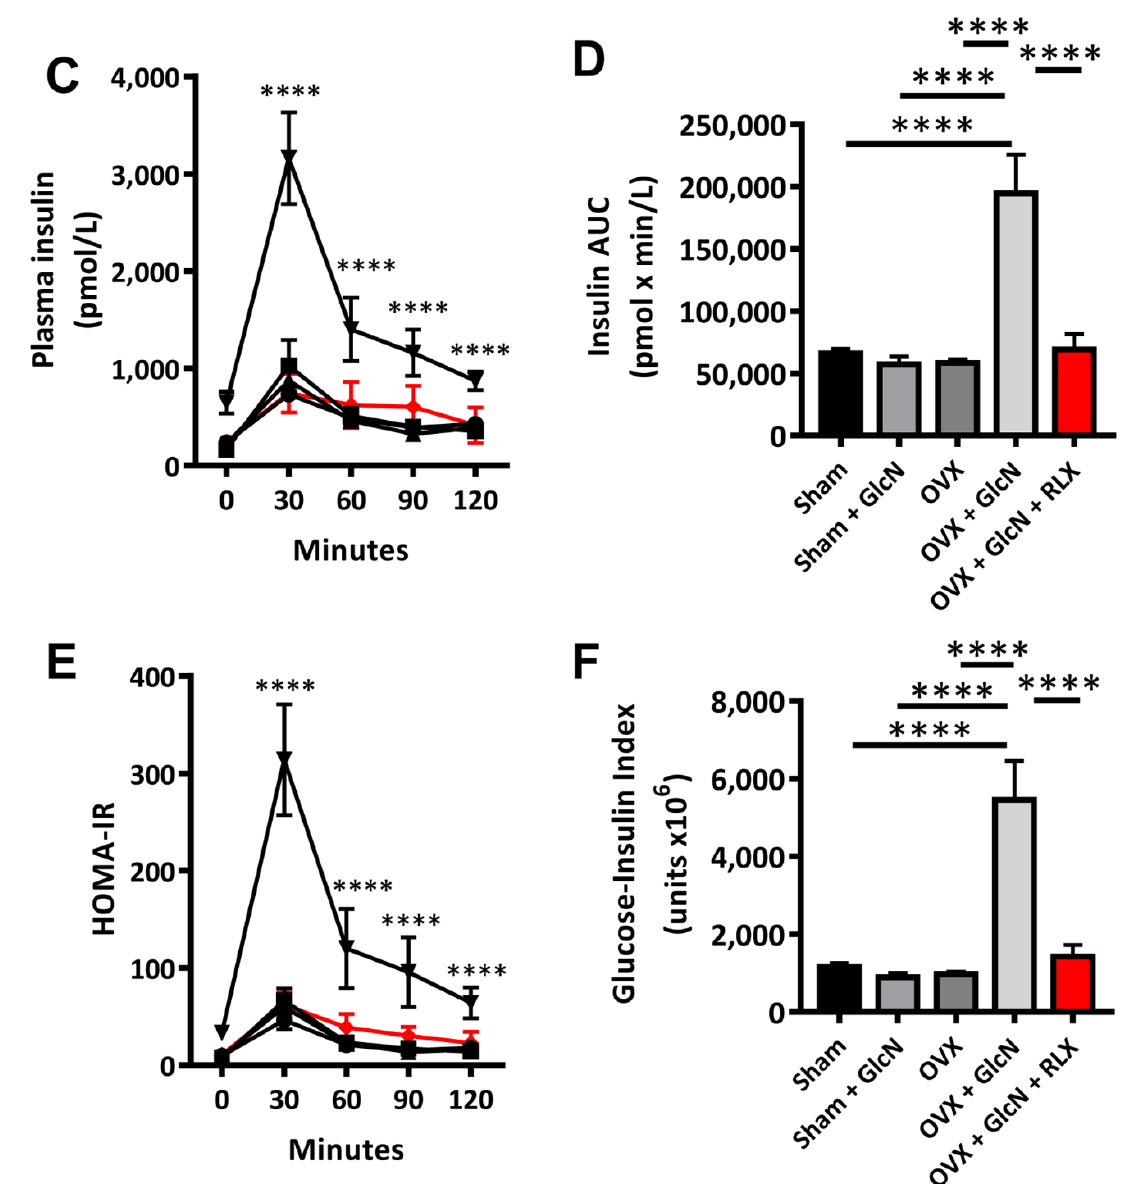
Figure 2. Levels and AUCs of plasma glucose, insulin, and HOMA-IR and glucose-insulin index in the IPGTT. The rats were randomly allocated to 5 treatments: (1) sham operation (Sham group), (2) sham with 750 mg/kg/d GlcN intraperitoneally (ip) injected for 14 days (Sham + GlcN group), (3) ovariectomy (OVX group), (4) ovariectomy with 750 mg/kg/d GlcN ip injected for 14 days (OVX+GlcN group), or (5) ovariectomy with 750 mg/kg/d GlcN ip injected for 14 days with subcutaneous RLX at 0.5 mg/kg/d. ( n = 8 in each group). ( A ) The OVX + GlcN group exhibited elevated plasma glucose levels over all other groups at 30, 60, 90, and 120 min after glucose loading. Although the level of glucose in the OVX + GlcN + RLX group was higher than that in the other 4 groups, the difference did not reach statistical significance. ( B ) The OVX + GlcN group exhibited higher AUC for plasma glucose concentrations in the IPGTT than that in all other groups. RLX reduced the glucose AUC to nearly the level of the Sham group. ( C ) After glucose loading, the OVX + GlcN group demonstrated higher plasma insulin levels at 30, 60, 90, and 120 min than that in all other groups. ( D ) The OVX + GlcN group exhibited higher AUCs for plasma insulin concentrations than that in all other groups. RLX reduced the glucose-insulin index and the insulin AUC nearly to the levels in the Sham group. ( E ) Only the OVX + GlcN group exhibited higher HOMA-IR. The HOMA-IR of the 4 other groups exhibited no significant differences in the IPGTT. ( F ) The OVX + GlcN group demonstrated a higher glucose-insulin index. RLX reduced the glucose-insulin index to nearly the level in the Sham group. * p < 0.05; ** p < 0.01; *** p < 0.001; **** p <